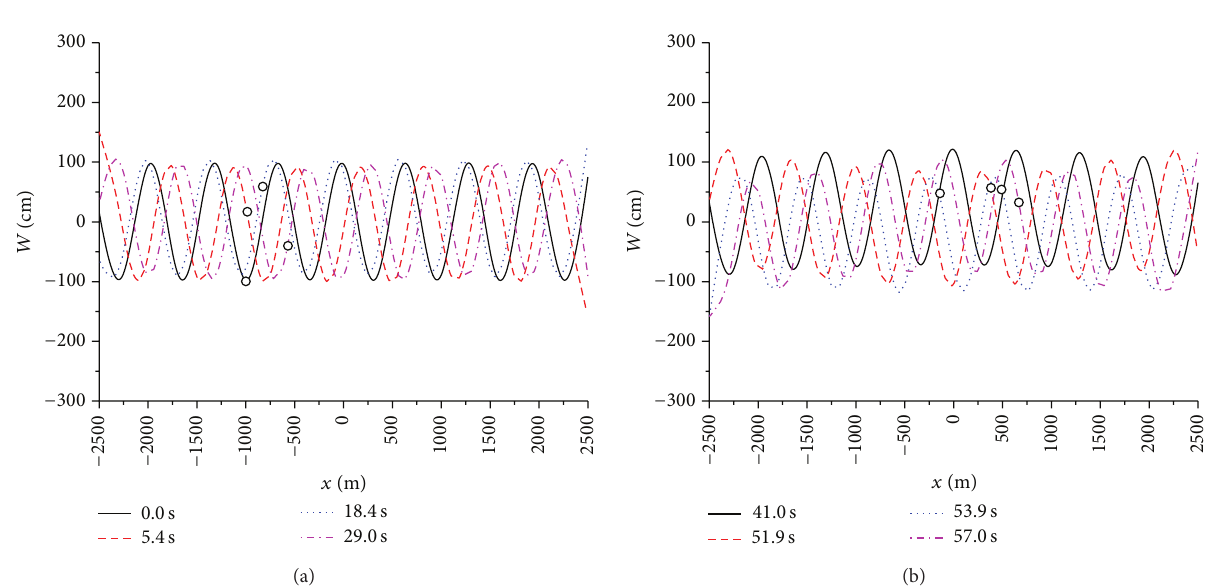
Figure 16: Spatial profiles of the deflection subjected to takeoff of airplane in regular wave